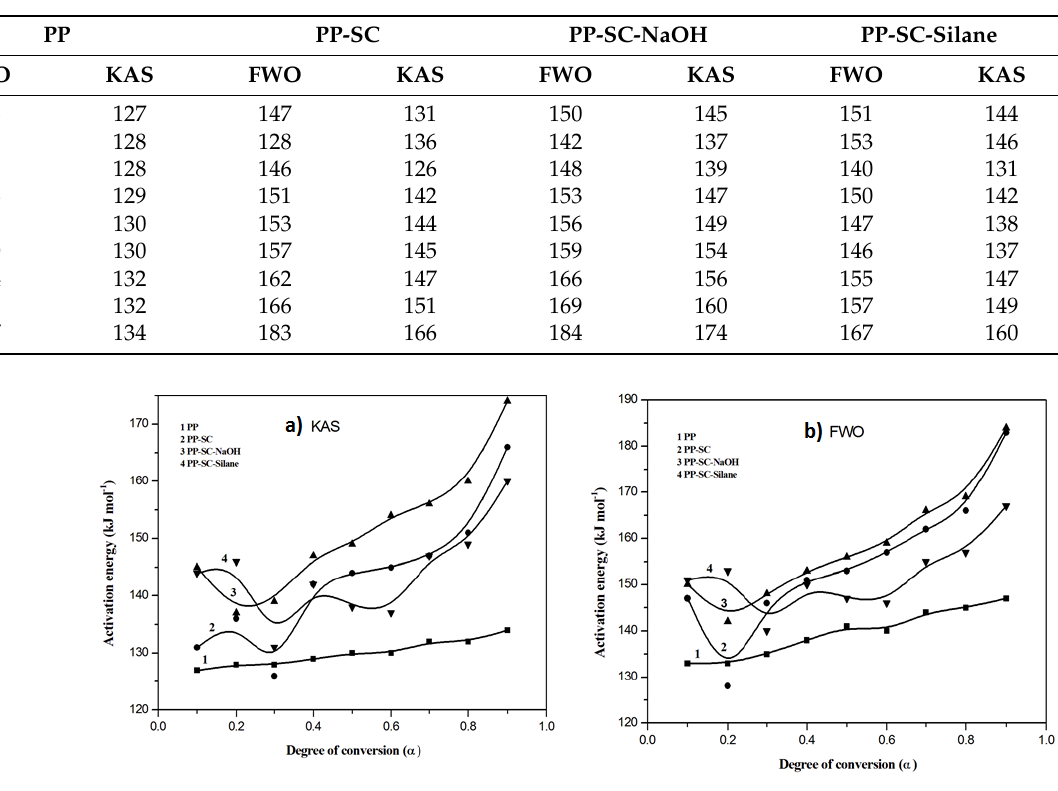
Table 3. Activation energy (kJ mol − 1 ) values of thermal degradation of PP and PP-SC composite.